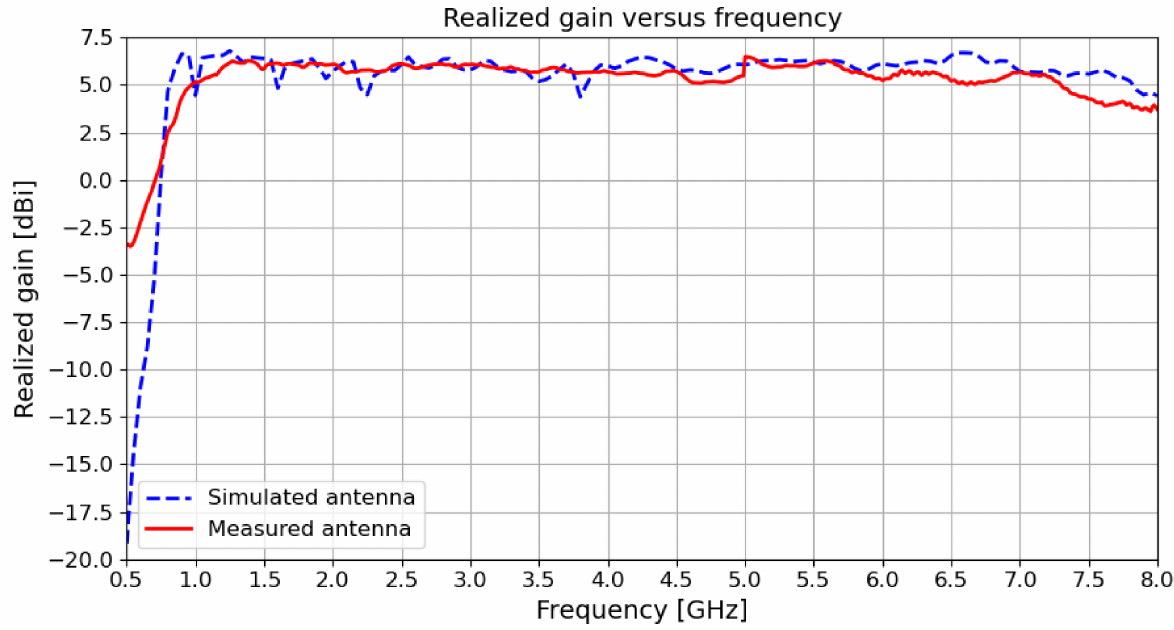
Figure 13. Comparison of the simulated and the fabricated realized gain of the conventional PLPDA